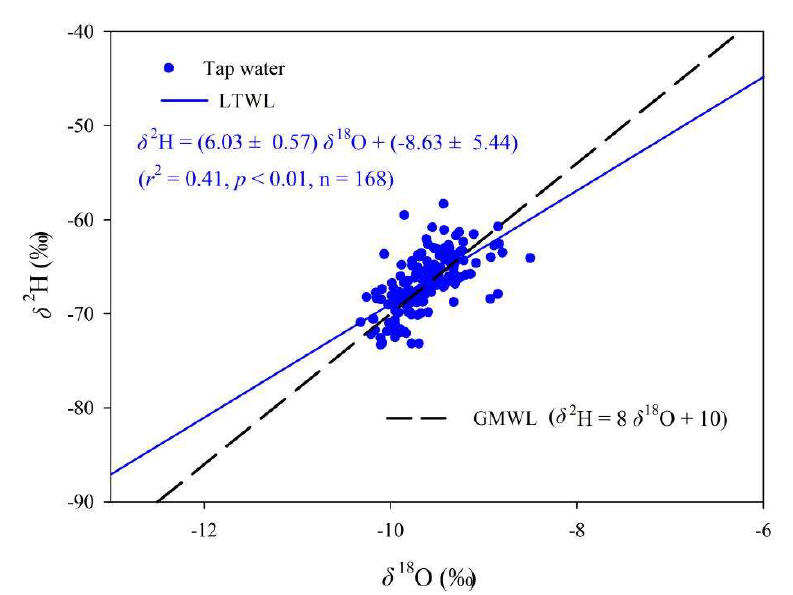
Figure 2. Relationship between δ 2 H and δ 18 O in tap water in Lanzhou. There were 168 tap water samples used in this chart, which were collected monthly at the seven sites from March 2016 to February 2018. (GMWL: Global Meteoric Water Line, LTWL: Local Tap Water Line).